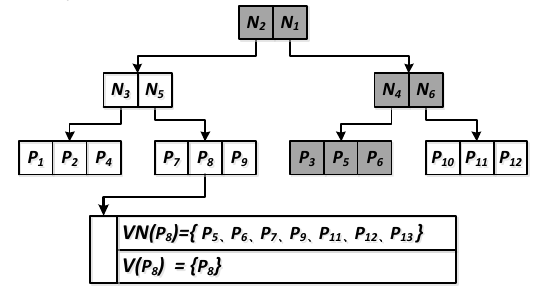
Figure 6. Range Query on